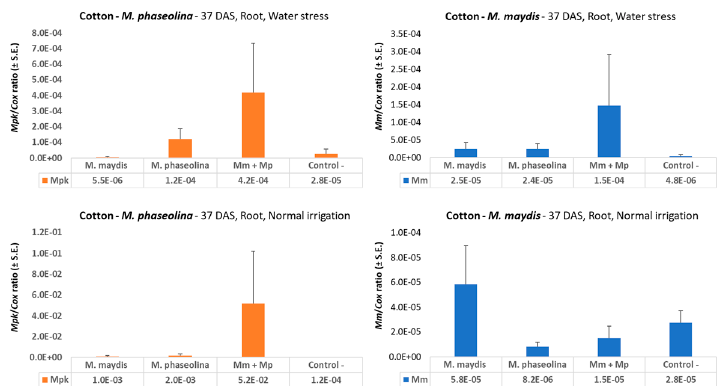
Figure 7. qPCR diagnosis of M. maydis and M. phaseolina in cotton sprouts. The full-growth season pot experiment under field conditions was conducted in the spring and summer of 2019. The charcoal- rot-susceptible cotton genotype Pima cotton, Goliath cv. was chosen for this experiment. The qPCR was used to identify the ability of the pathogens, alone or in mixed inoculation, to infect and colonize the cotton root tissues 37 days after sowing (DAS). The control is soil from a nearby field with minor levels of M. maydis or M. phaseolina infestation. The y-axis values are M. maydis relative DNA ( Mm ) or M. phaseolina relative DNA ( Mpk ) abundance, normalized to the cytochrome c oxidase ( Cox ) DNA. Vertical upper bars represent the standard error of the mean of 10 replications (pots, each containing one plant).